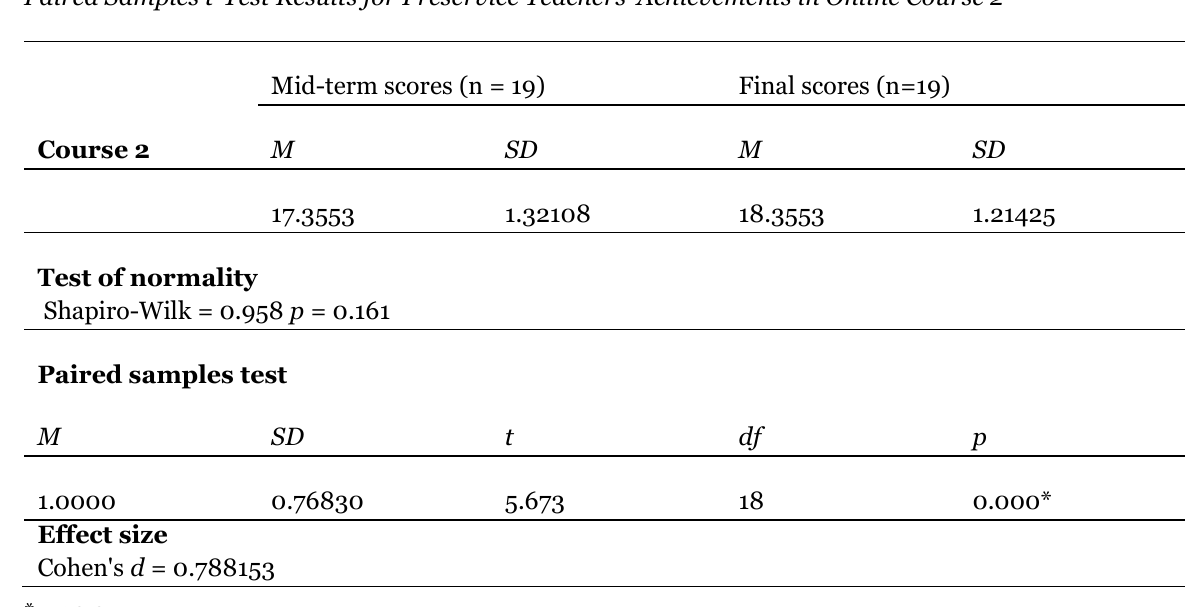
Paired Samples t-Test Results for Preservice Teachers’ Achievements in Online Course 2